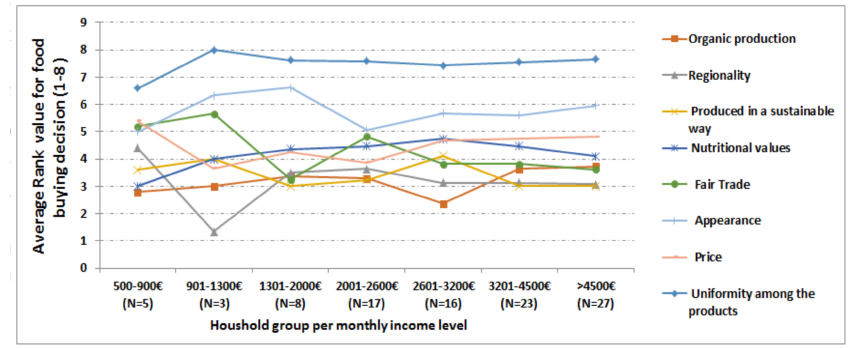
Figure 4. Description of food buying decision ranking according to income level based household groups ( N =